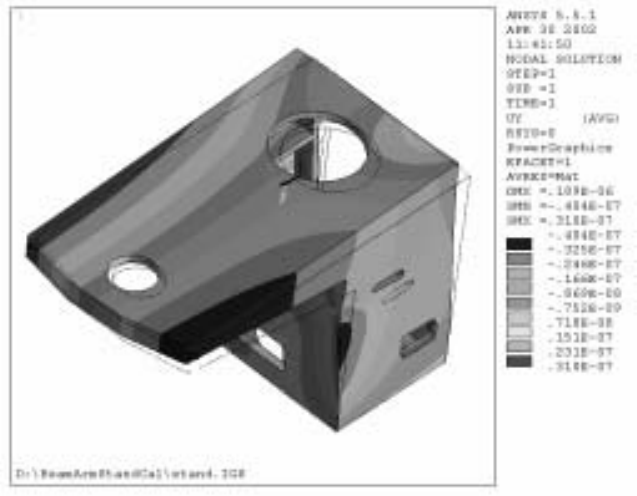
Fig. 19. Bond head stand displacement with 1 N exciting force at point A with small hammer.